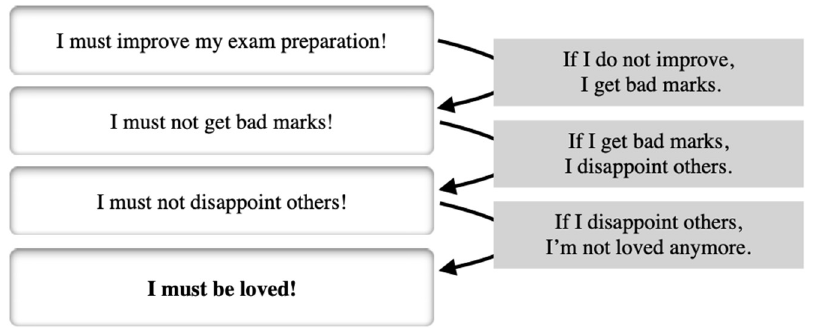
Figure A1. Exemplary “chain of subjective imperatives”, the white boxes display the “subjective imperatives”, the imperative written in bold letters is the “core imperative”, the grey boxes give the gist of the “if-then-phrases” that link the imperatives (according to Wagner [2007] 2021).